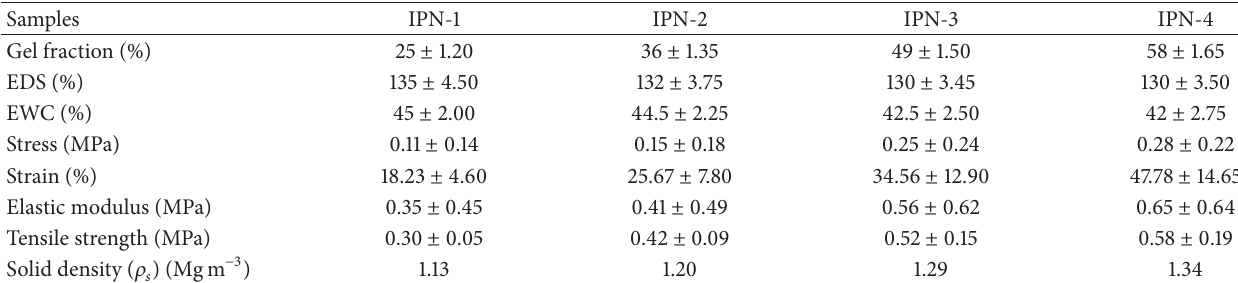
Table 2: The properties of IPN PVA/GE hydrogels after one freezing-thawing cycle.